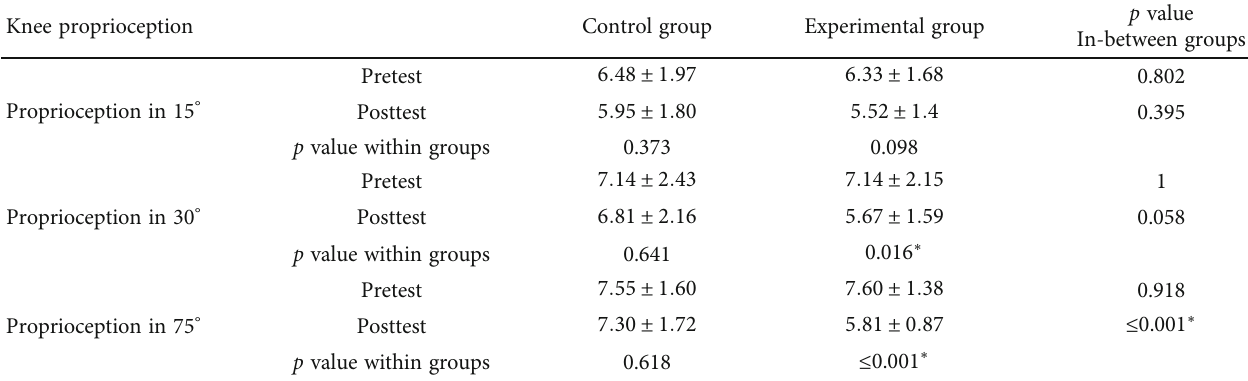
Table 4: Knee proprioception in 15 ° , 30 ° , and 75 ° within and in-between